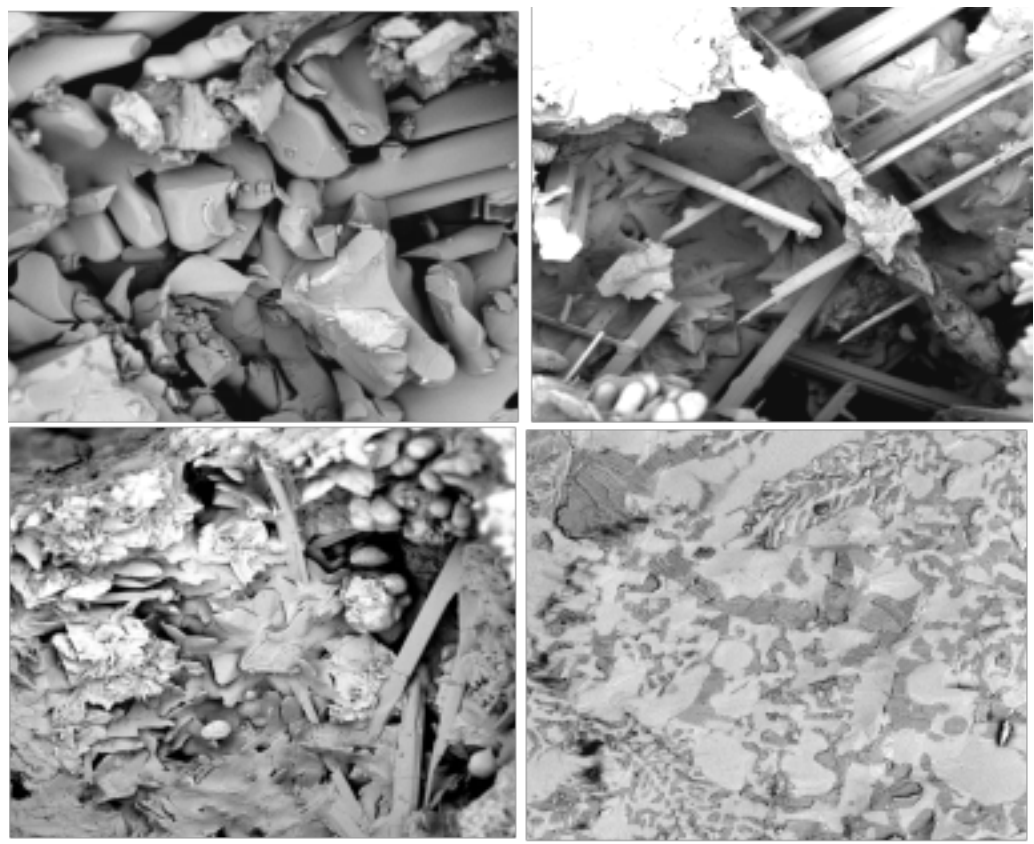
Figure 8: SEM images of reconstructed steel slag with different CaF 2 contents. (a) 0, (b) 1, (c) 3, and (d) 5 wt% CaF 2 .